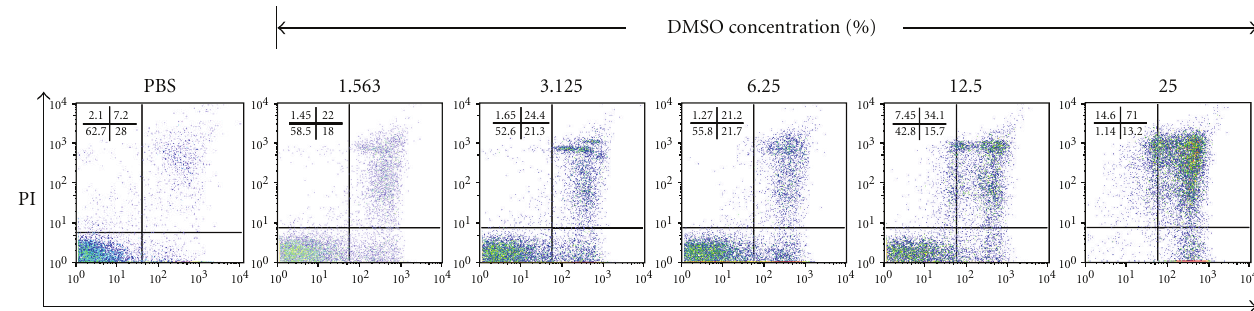
Figure 6: DMSO induces e ff ector T cell apoptotic death in vitro. OT-I splenocytes were prepared and incubated with indicated concentrations of DMSO (ranging 1.563%–25%) for 2 hours. Cells were then double stained with FITC-annexin V and propidium iodide (PI) and analyzed by flow cytometry. Gate was set on lymphocytes according to scatter criteria. The percent of single- and double-stained cells is indicated. The results are representative of two separate